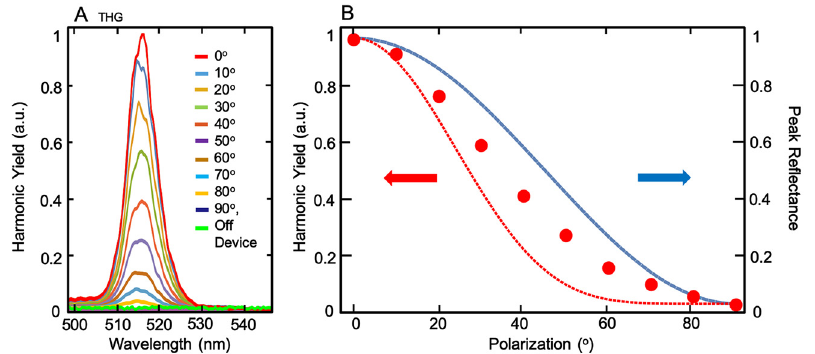
Figure 3: Grating polarization